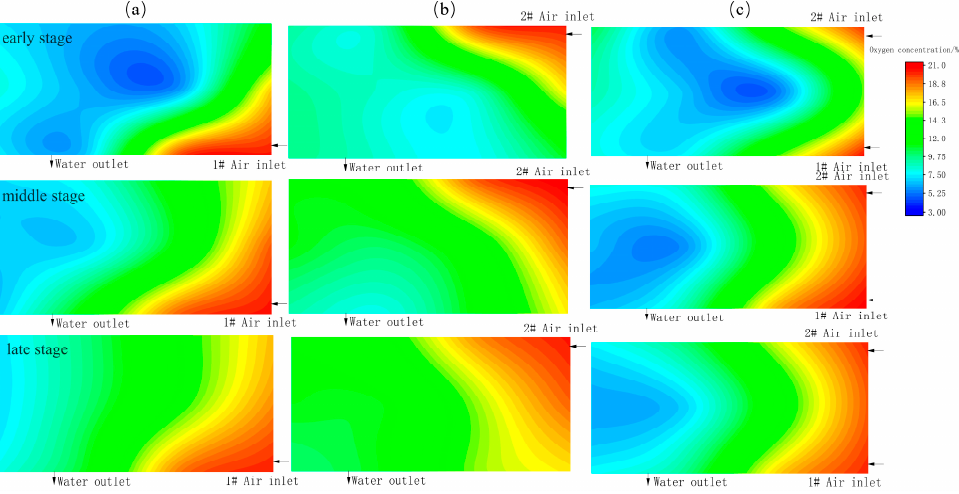
Figure 5. Change characteristics of SC hazardous area in the goaf under different air leakage channels. ( a ) 1# air leak, ( b ) 2# air leak, ( c ) Both channels 1# and 2# leak air.